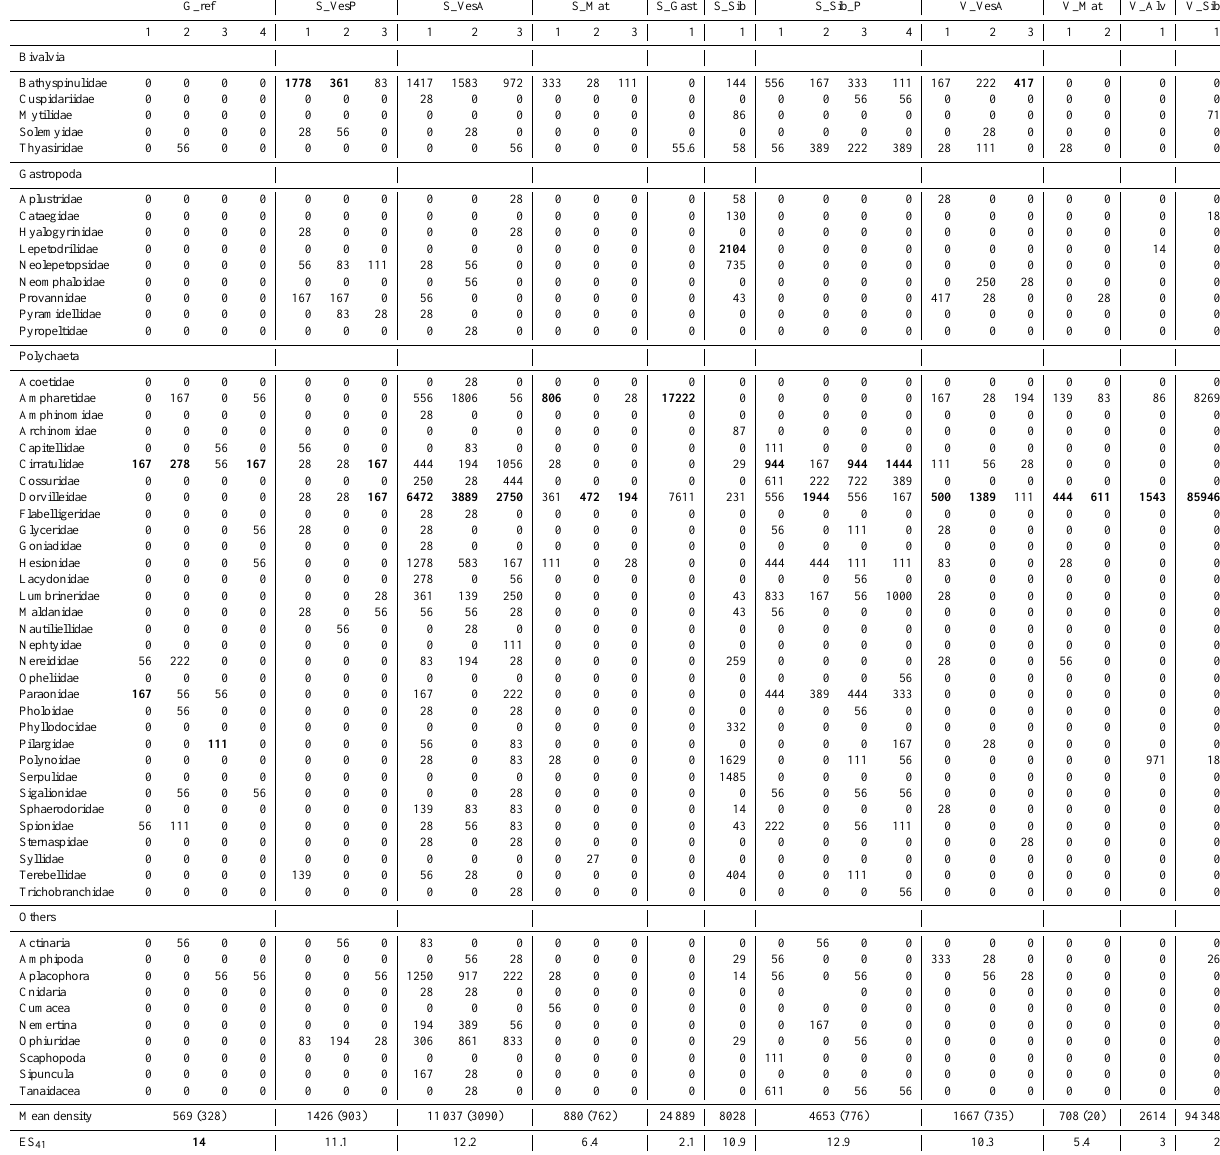
Table 6. Macrofaunal community composition (expressed in terms of density: indm − 2 ) in the Guaymas Basin assemblages at the family level, including total densities (indm − 2 ) and ES 41 diversity. Standard deviations are given in parentheses. The highest values for each assemblage are highlighted in